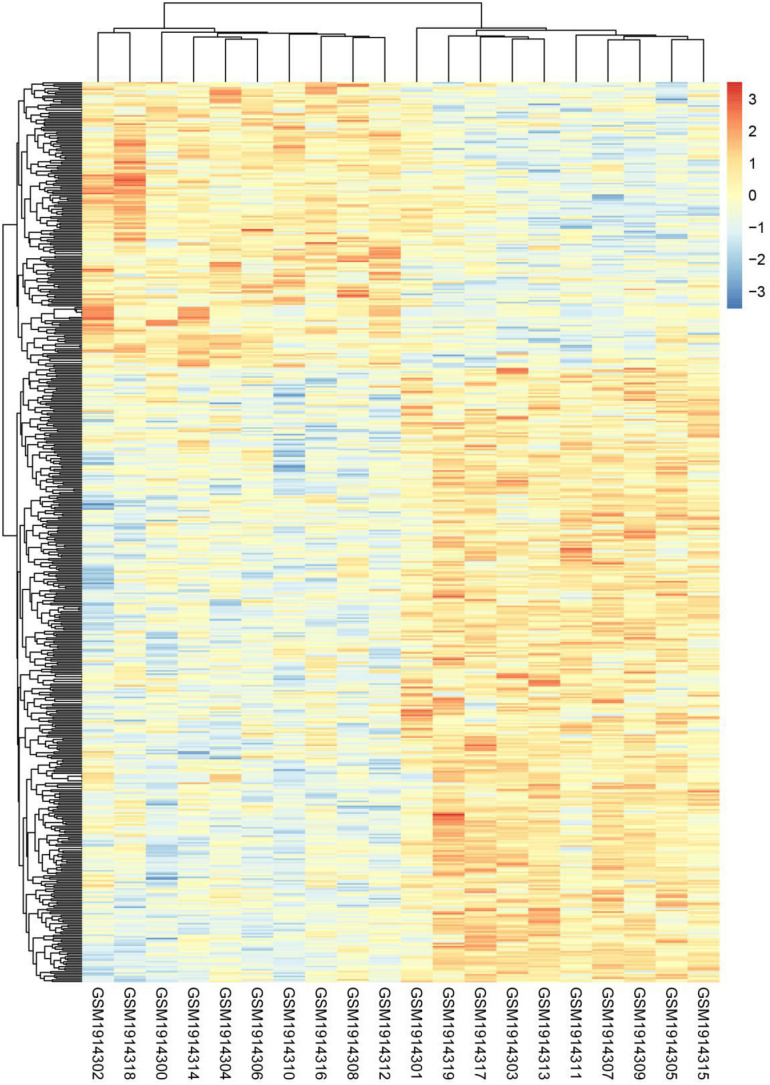
DEGs hierarchical cluster analysis between aerobic and anaerobic exercise groups in GSE74194 database. Three hundred seventy-three up-regulated DEGs related to aerobic exercise and 174 down-regulated DEGs related to aerobic exercise were identified. Red, up-regulated genes, blue, down-regulated genes.